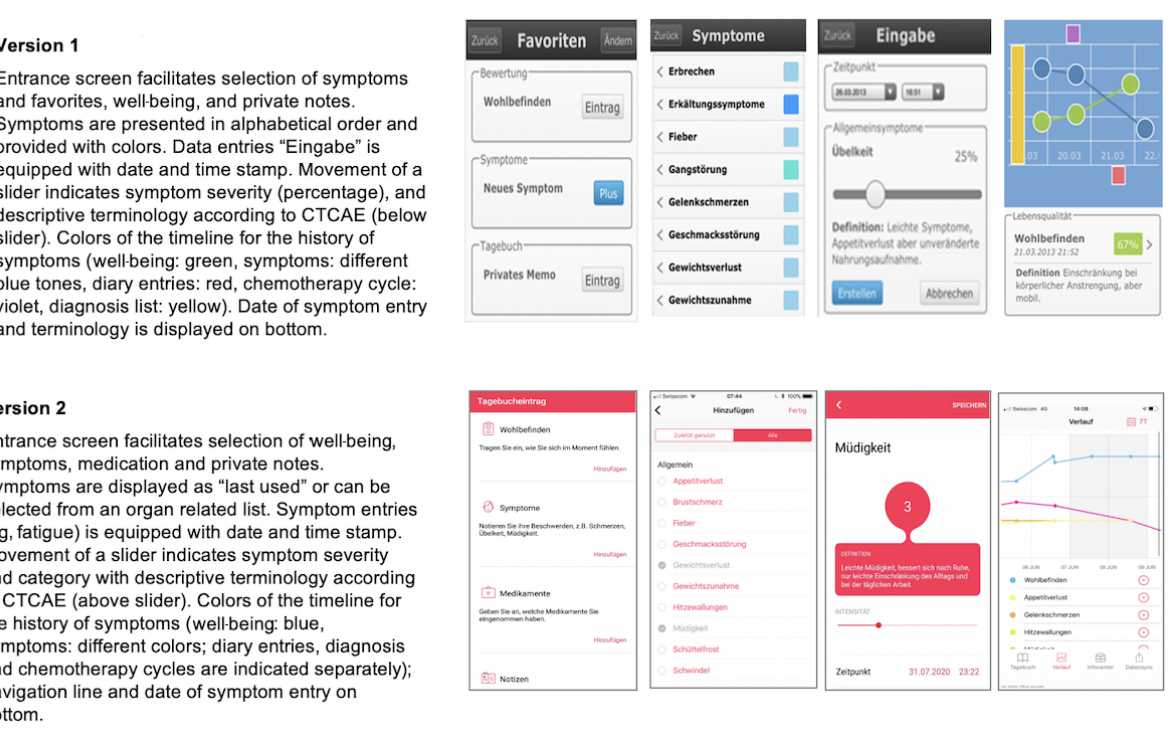
Figure 1. Different graphical displays of the two app versions. CTCAE: Common Terminology Criteria for Adverse